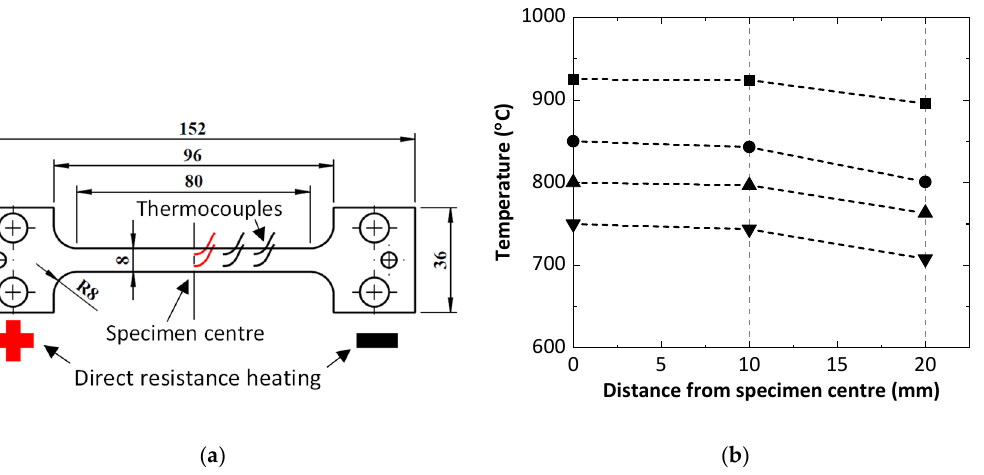
Figure 2. Resistance heating of dog-bone specimens for uniaxial tensile tests at high temperatures [10]: ( a ) setup of resistance heating together with the thermocouples welded at the specimen center providing signals for feedback control of the specimen temperature and ( b ) temperature distributions along the specimen length direction.